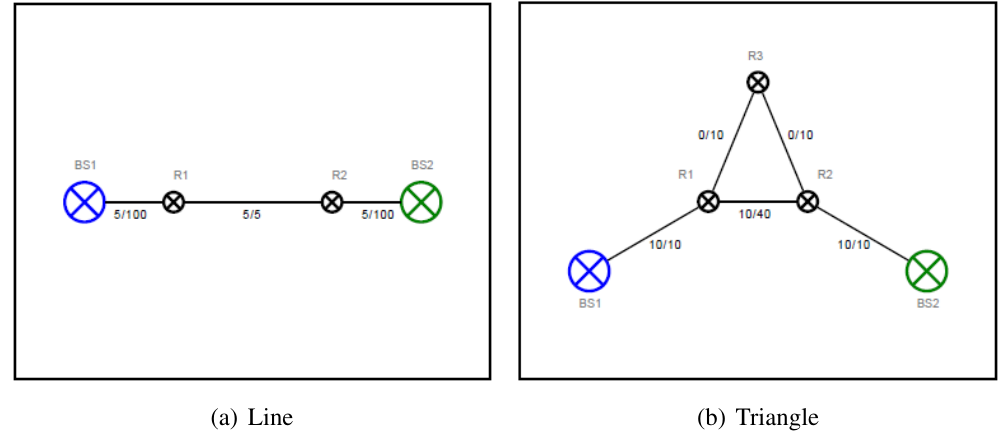
Figure 2. Case studies of connectivity